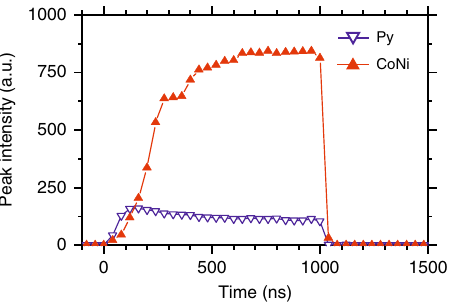
Fig. 3 Evolution of the nonlinear damping in the time domain. Time dependence of the peak BLS intensity in response to the 1 μ s long pulse of current obtained for the Py and CoNi disks, as labeled. The data were recorded at H 0 = 2.0 kOe and I = 1.07 I C